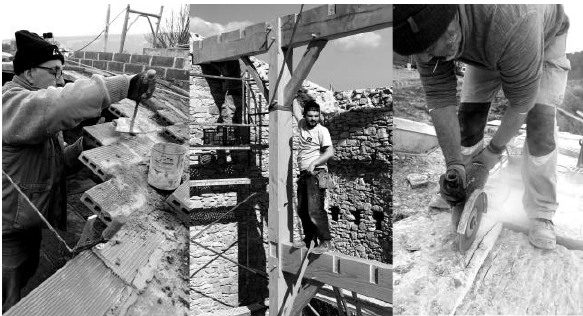
Figure 10. Little of the final result would have been possible without the shared authority with expert